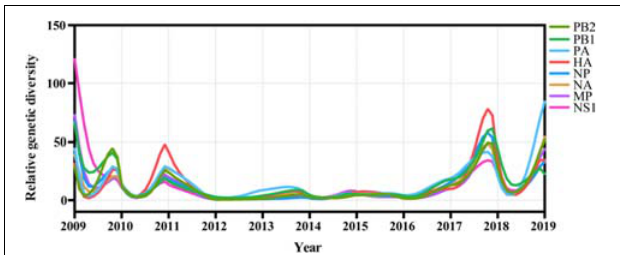
FIGURE 5 | Population dynamics of genetic diversity of A/H1N1pdm virus in China during 2009–2019. The relative genetic diversity of each gene was estimated using the Gaussian Markov Random Fields (GMRF) Skyride model.